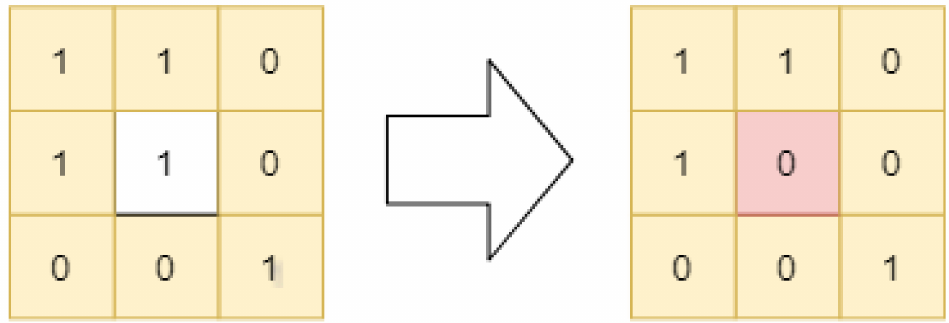
Figure 3. The schematic diagram of majority. There are only four white pixels (value equal to 1) among the eight pixels, so it will be set to black (value equal to